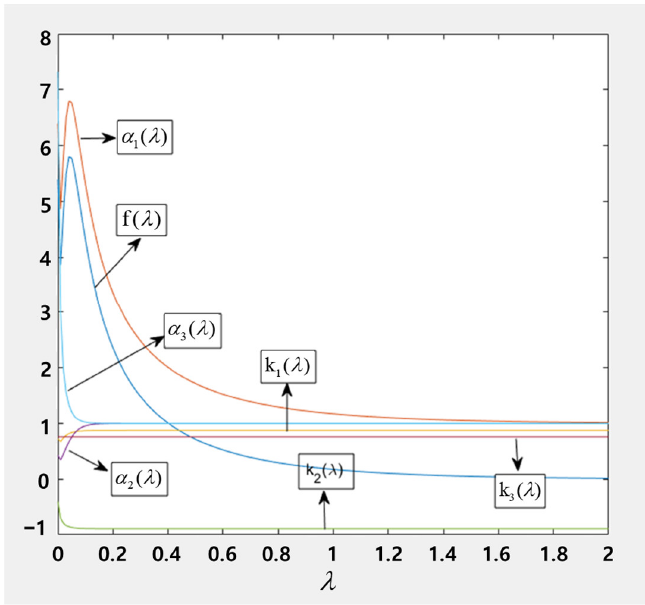
Figure 2. α  (λ) and   (λ) by the parameters in Table 1. Figure 2. α i ( λ ) and k i ( λ ) by the parameters in Table